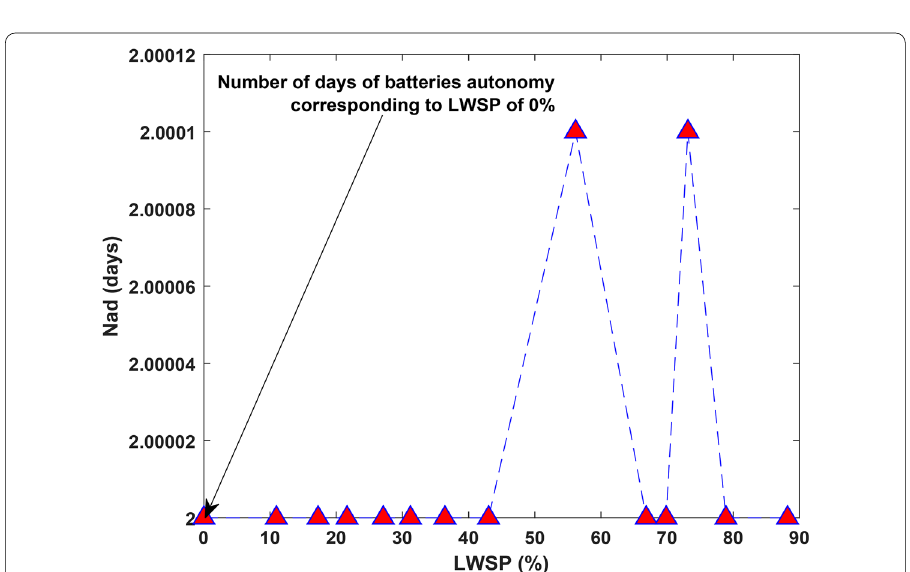
Fig. 8 Variation in the number of days of reservoir autonomy on Pareto